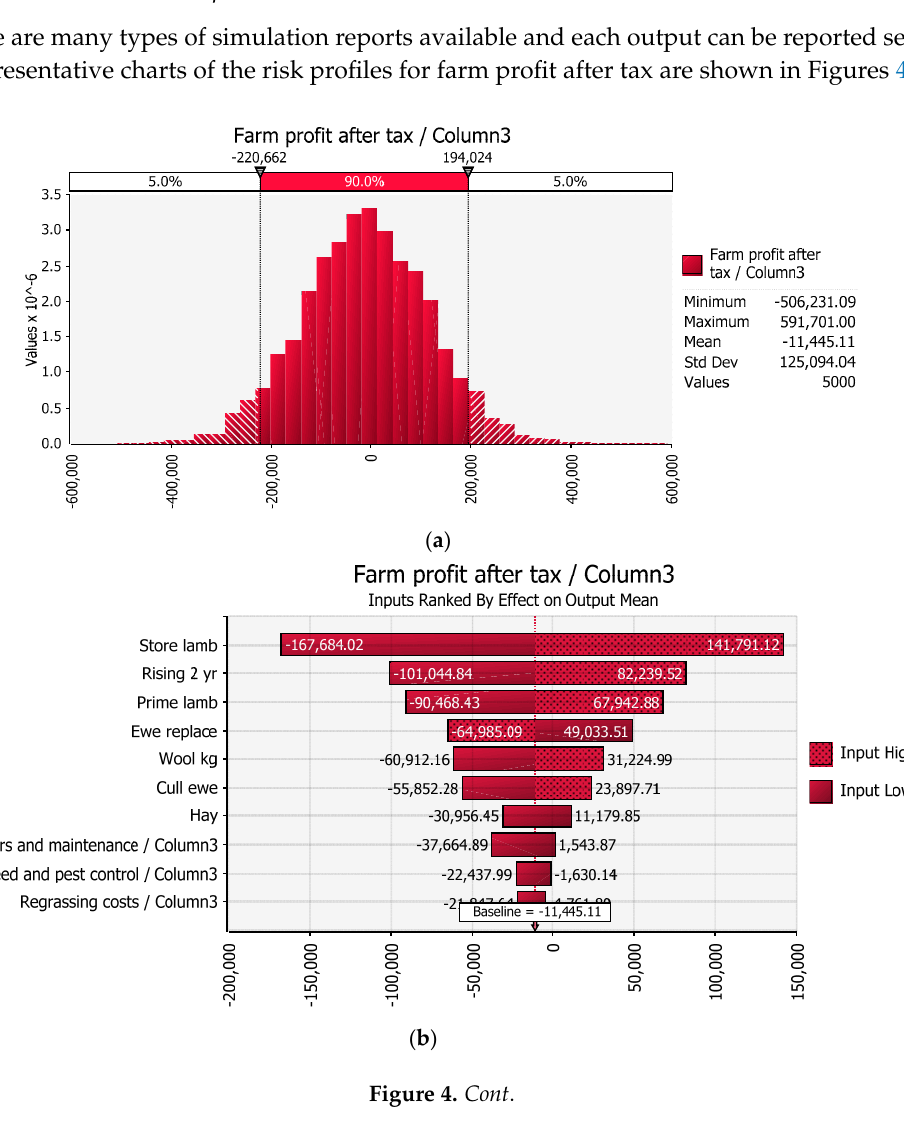
( c ) Figure 4. “@Risk” simulated risk profile for the sheep and beef farm, showing distribution of after tax profit ( a ); tornado chart ( b ); cumulative distribution of profits ( c ). ( a ) - 0 . 4